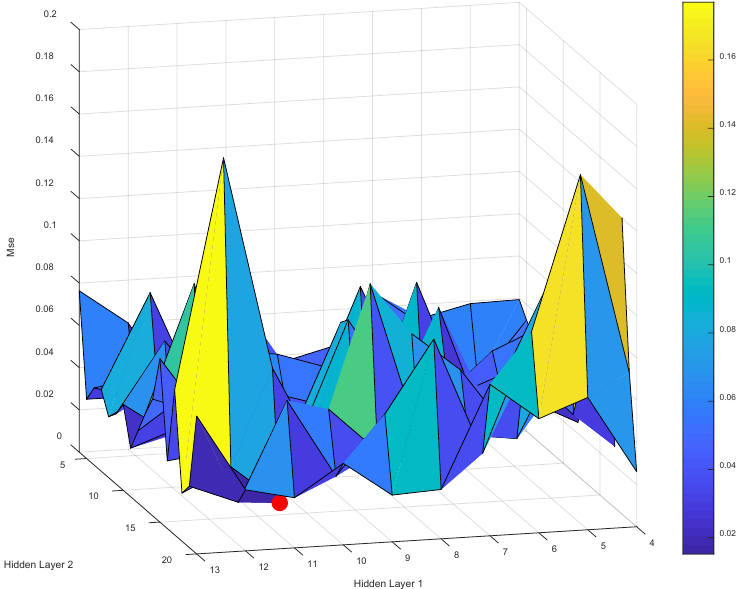
Figure 8. The effect of the hidden layer nodes on the training error of SCG-ANN.